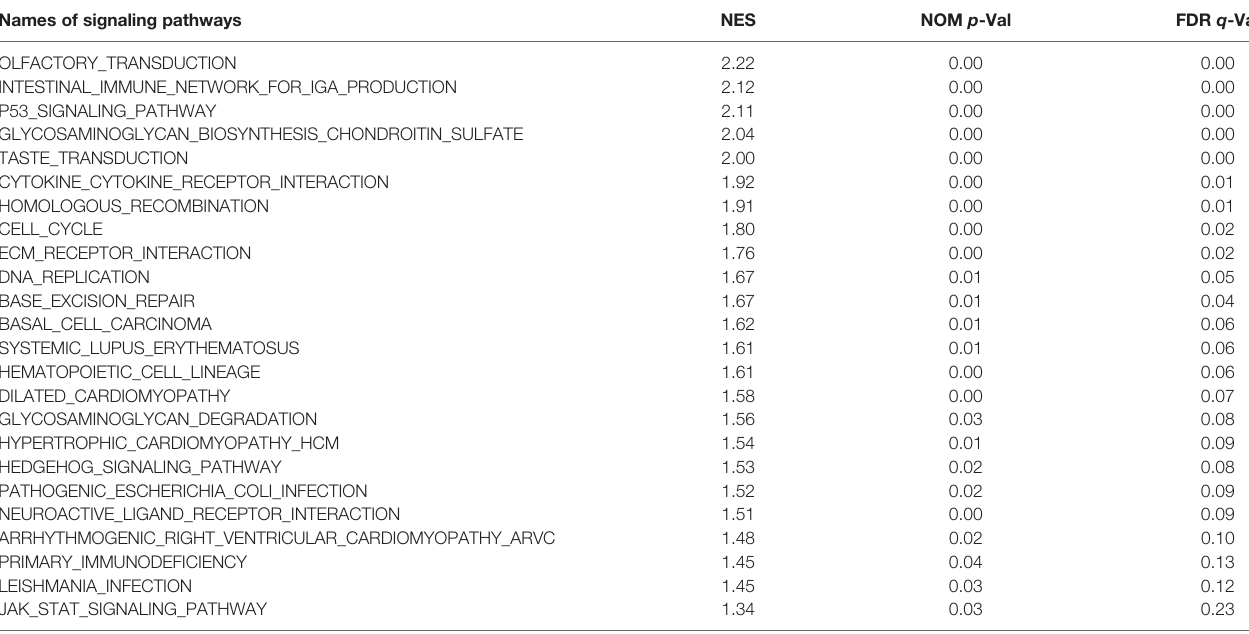
TABLE 3 | GSEA analysis of signaling pathways associated with patients with high risk scores. Names of signaling